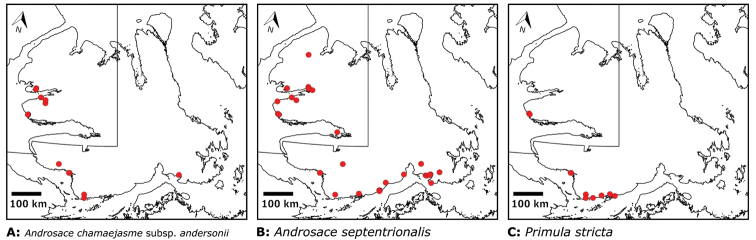
Species distribution maps. Primulaceae: AAndrosace
chamaejasme
subsp.
andersoniiBAndrosace
septentrionalisCPrimula
stricta.